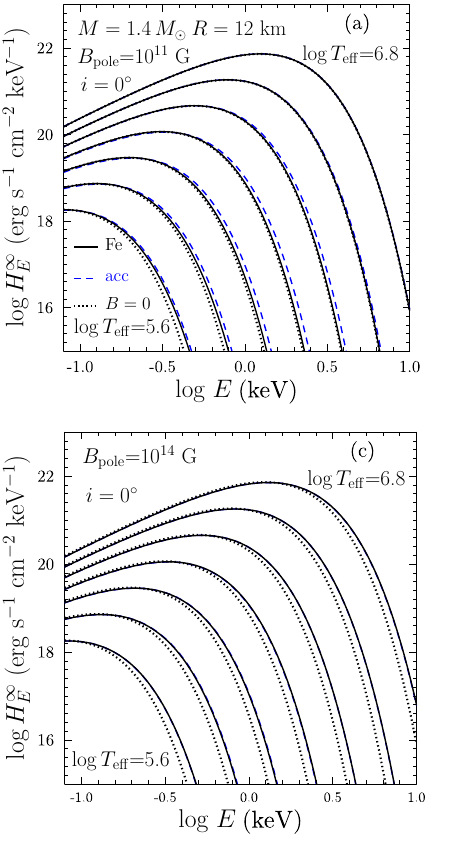
Figure 3. Thermal spectral fluxes observed from magnetic poles for a neutron star with M = 1.4 M and R = 12 km at three values of B pole = 10 11 G ( a ), 10 13 G ( b ), and 10 14 G ( c ) at log T eff = 5.6, 5.8, ..., 6.6 assuming iron (solid lines) or accreted (dashed lines) heat blankets. The dotted lines refer to non-magnetic star to guide the